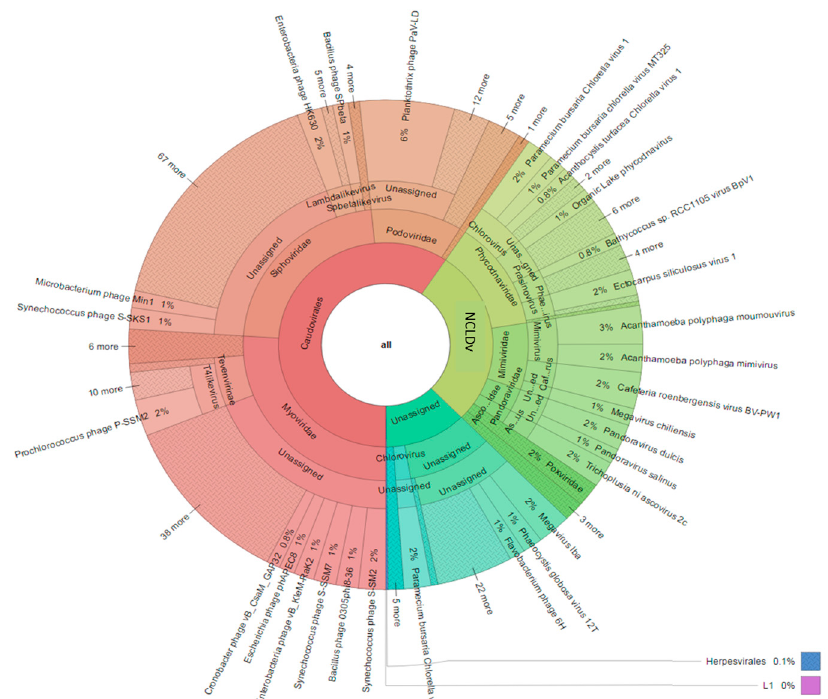
Figure 6. Krona chart of contigs annotation using the Virus db.